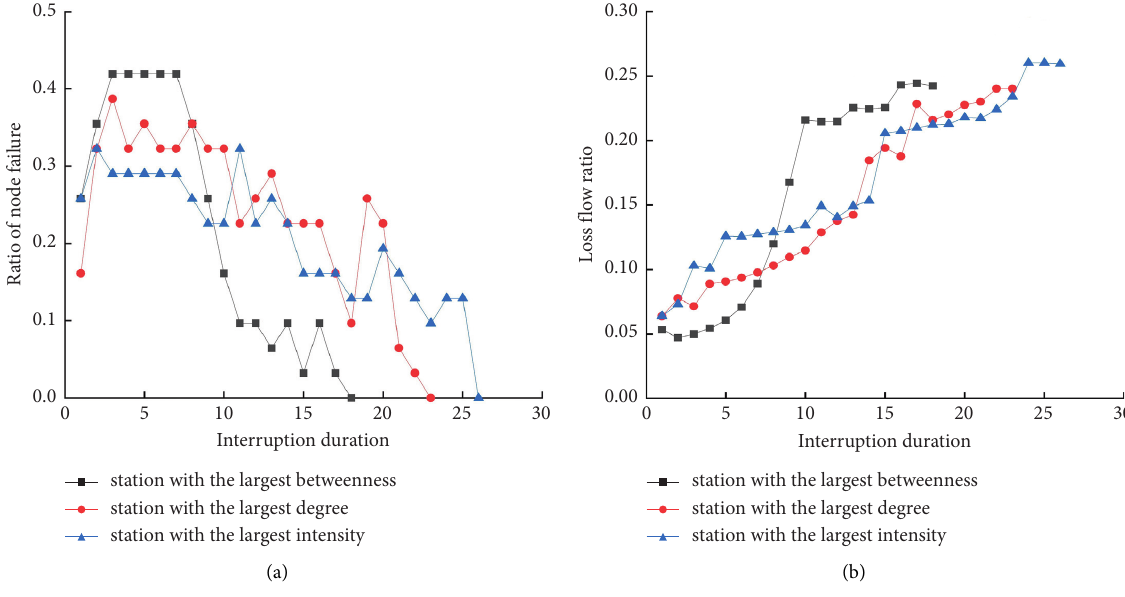
Figure 8: The impact of maliciousness on network vulnerability ( ε � 0 . 25). (a) Ratio of node failure. (b) Loss flow